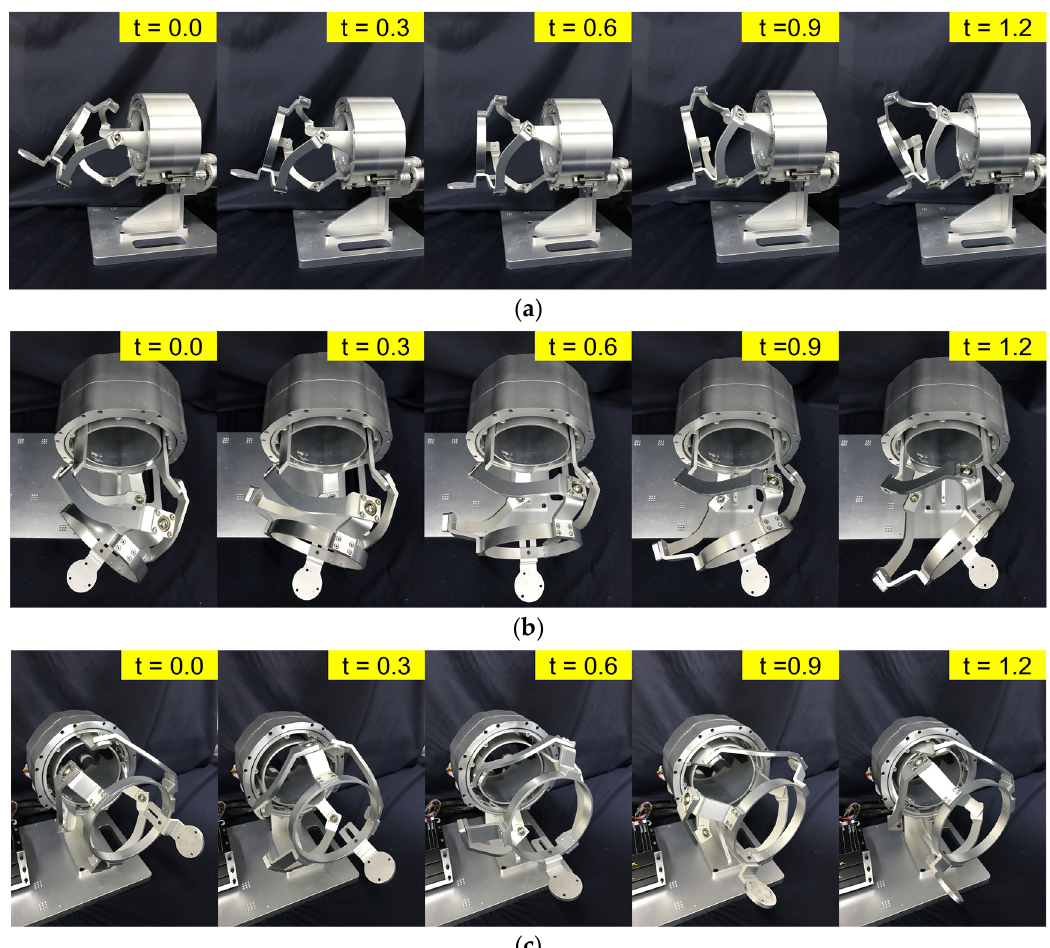
Figure 4. Design and motion example of the FC-WREI: ( a ) AA motion, ( b ) FE motion, ( c ) PS motion.